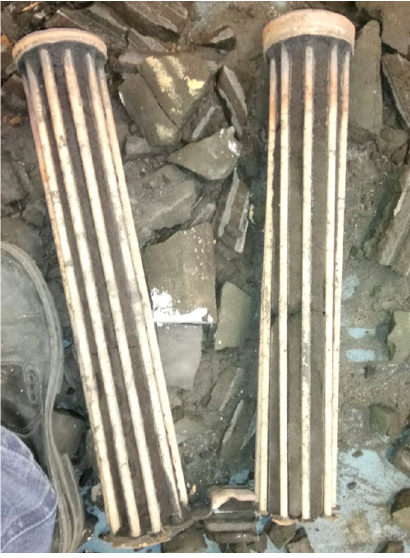
Figure 4. Welding rods of different lengths and diameters (the length of rods was 40 cm; the diameters were 8 mm and 6 mm).